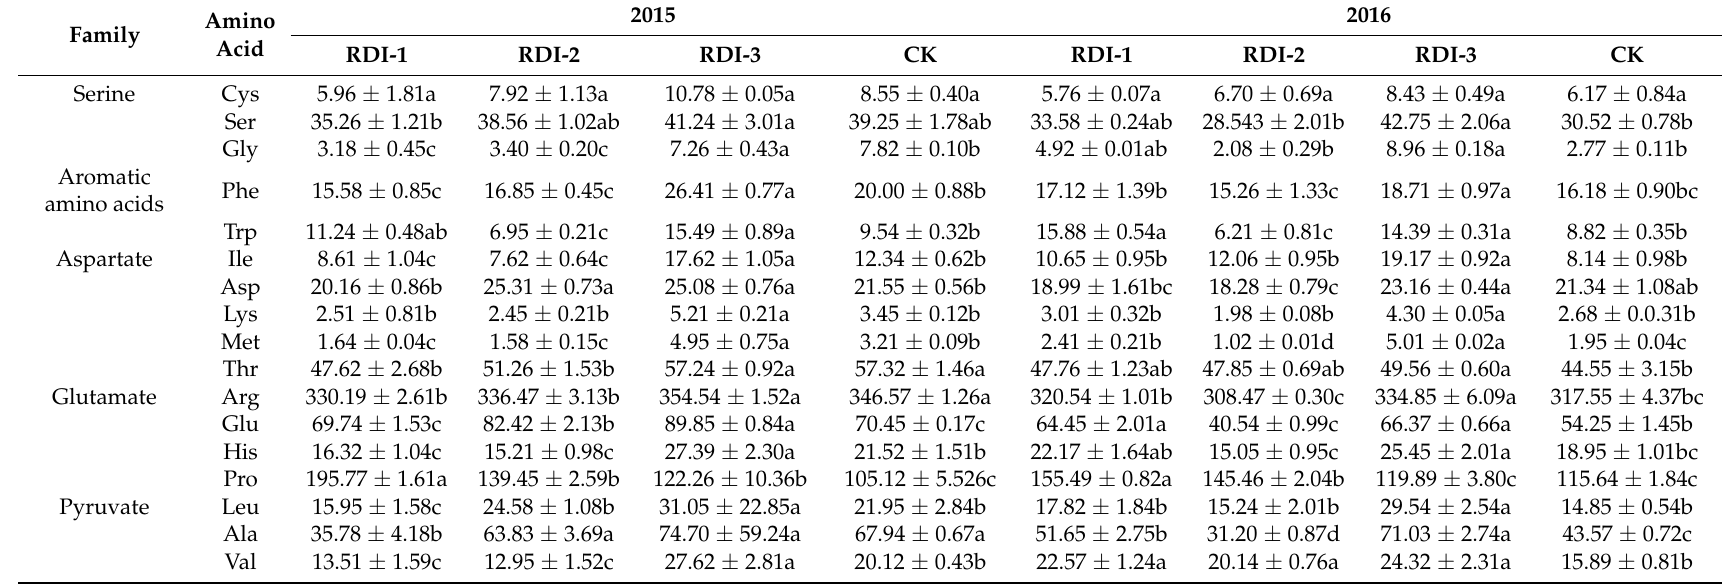
Table 2. Amino acid concentrations (mg/L) in grapes from untreated (CK) and treated